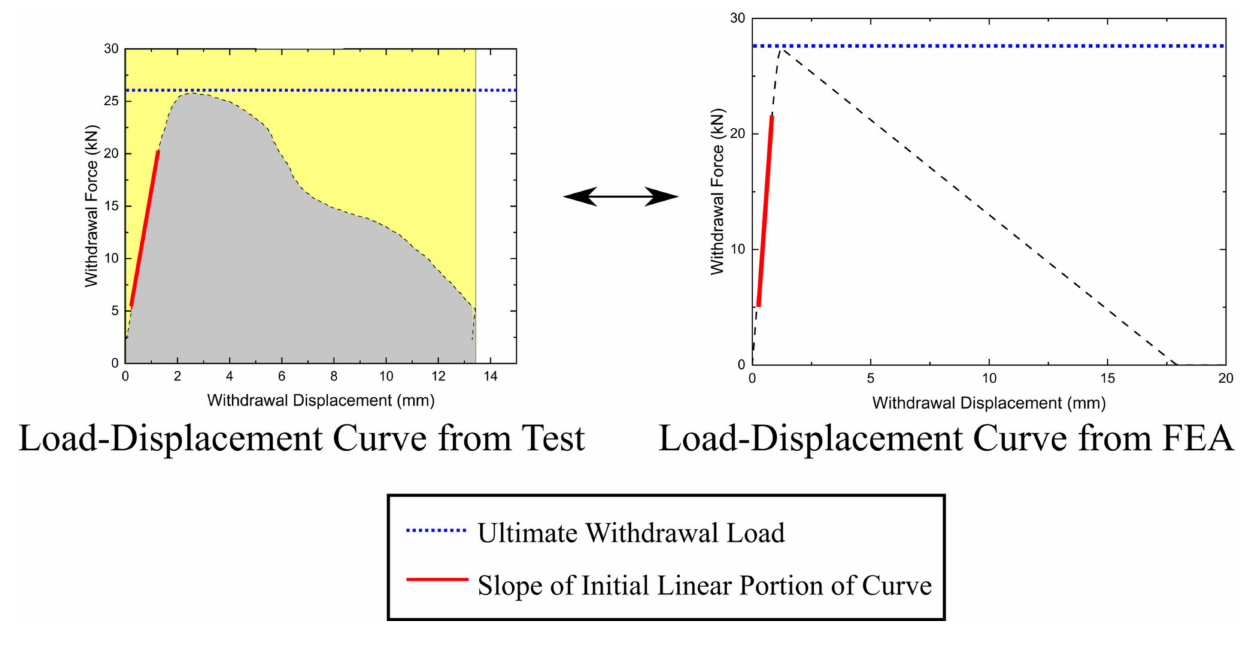
Figure 13. Comparison of the load-displacement curve from finite element analysis (FEA) and withdrawal test.